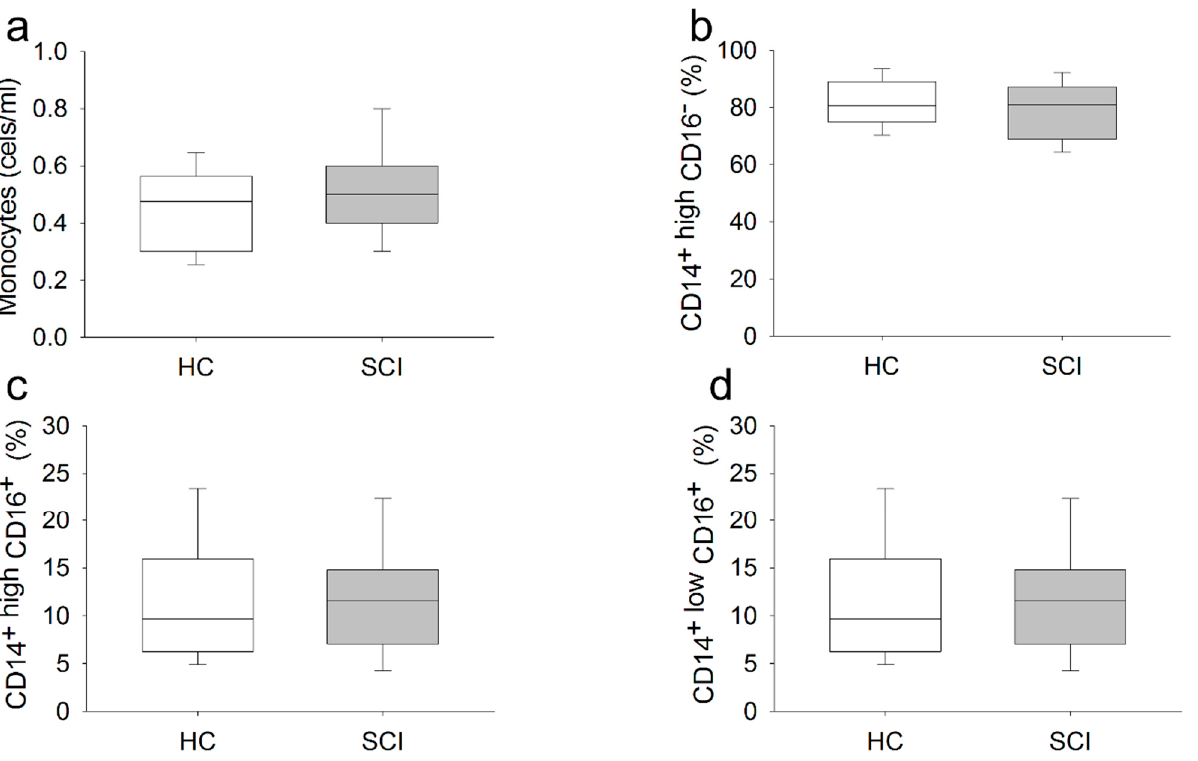
Figure 1. Absolute number of circulating monocytes and the distribution of monocyte subsets in chronic SCI patients. Absolute number (cells/ μ L) of circulating monocytes: ( a ) and the percentages of the CD14 +high CD16 − ; ( b ) CD14 +high CD16 + ; ( c ) and CD14 +low CD16 + ; ( d ) monocyte subsets in chronic SCI patients (gray box) and healthy controls (white box).